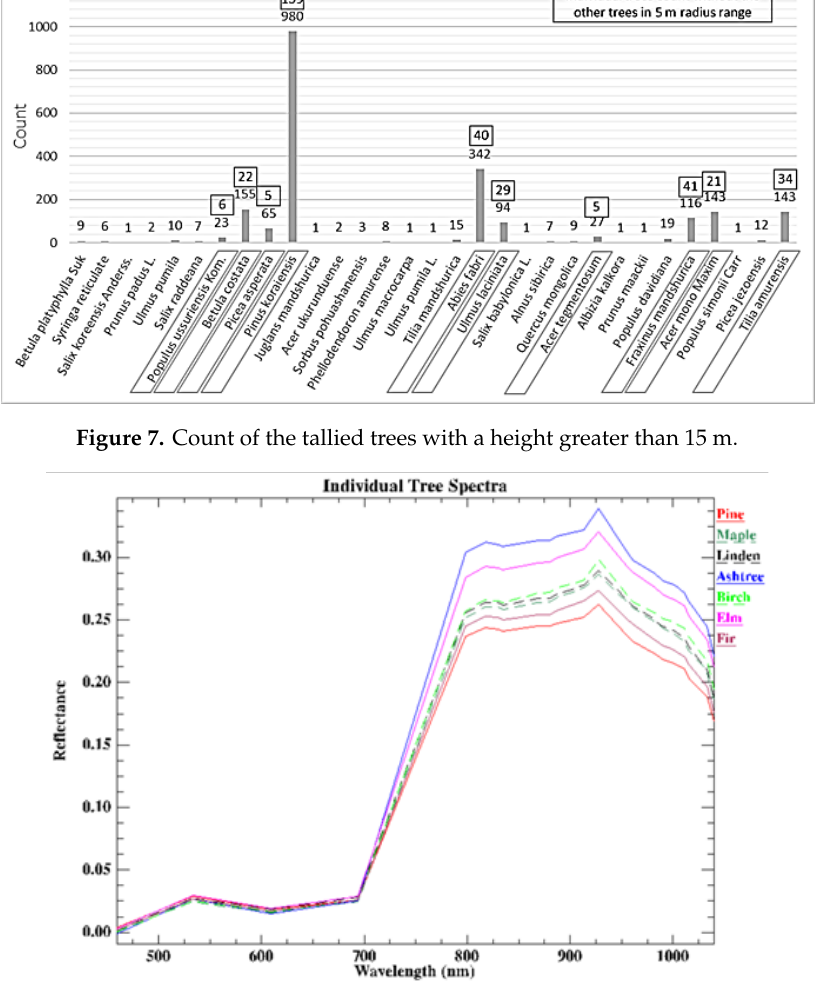
Figure 8. Individual tree mean spectra of the main species.